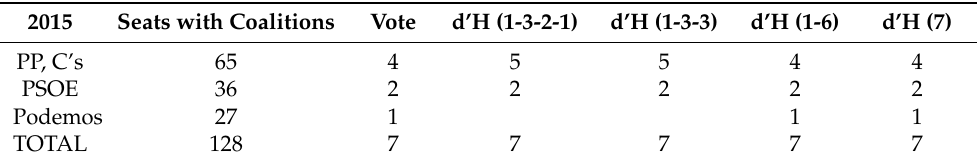
Table 13. Relationship between the number of positions obtained and the d’Hondt distributions in the X